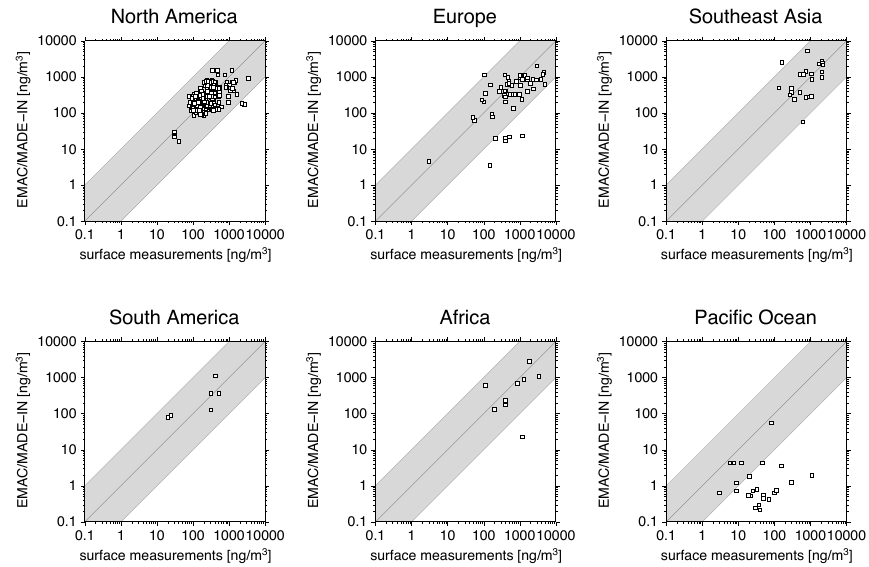
Fig. 3. Comparison of modeled and observed BC mass concentrations at surface level for different regions. Each square corresponds to one measurement site. The shaded regions indicate a ratio of measurements to model results within the range of 0.1 and 10. See text for more details on the observational data used.